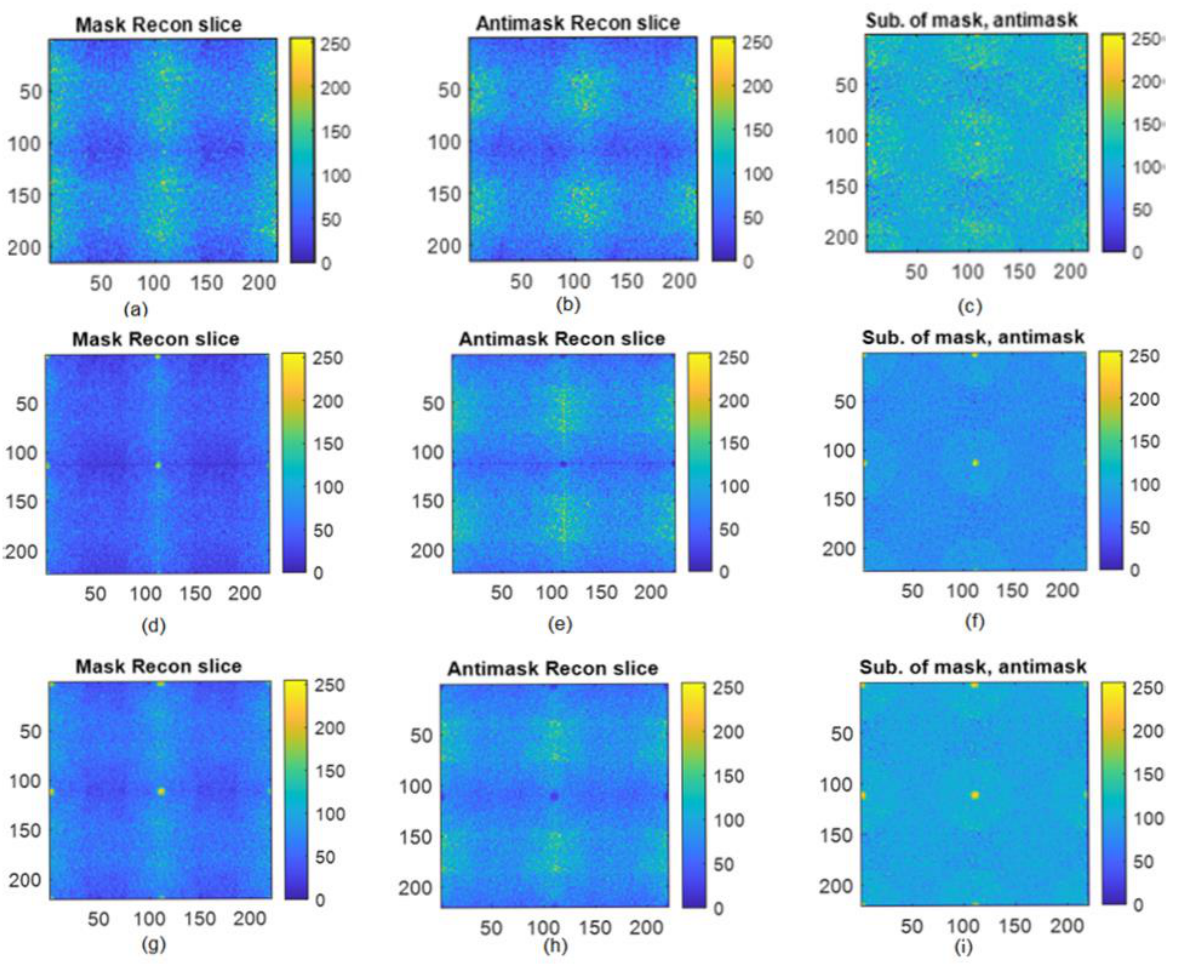
Figure 6. Reconstructed slice of an 8 mm tumor from different depths: ( a ) Breast phantom recon- structed slice at 12.5% depth of tumor using mask, ( b ) Breast phantom reconstructed slice at 12.5% depth of tumor using antimask, ( c ) difference of mask and antimask, ( d ) Breast phantom reconstructed slice at 25% depth of tumor using mask, ( e ) Breast phantom reconstructed slice at 25% depth of tumor using antimask, ( f ) difference of mask and antimask at 25% depth of tumor, ( g ) Breast phantom reconstructed slice at 50% depth of tumor using mask, ( h ) Breast phantom reconstructed slice at 50% depth of tumor using antimask, ( i ) difference of mask and antimask at 50% depth of tumor.